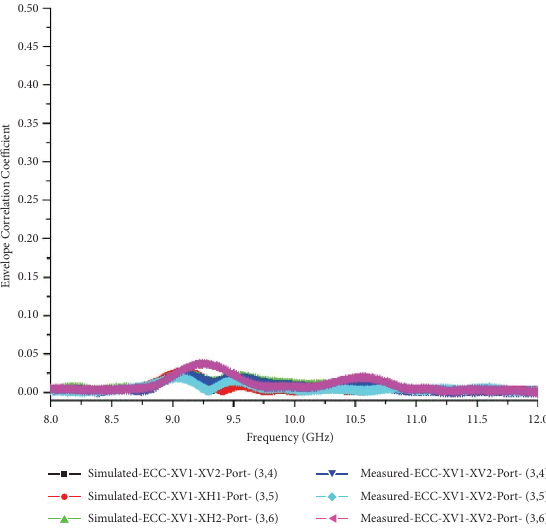
Figure 15: MIMO-Freq vs.